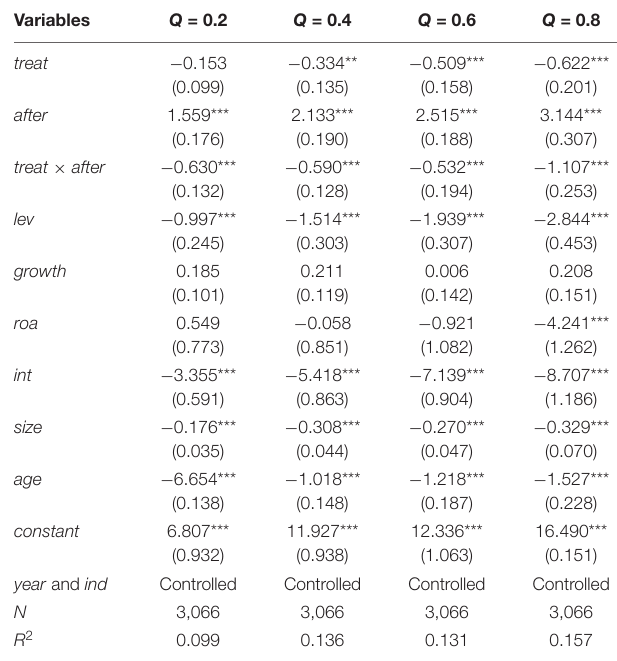
TABLE 6 | Quantile estimates results of corporate R&D intensity.